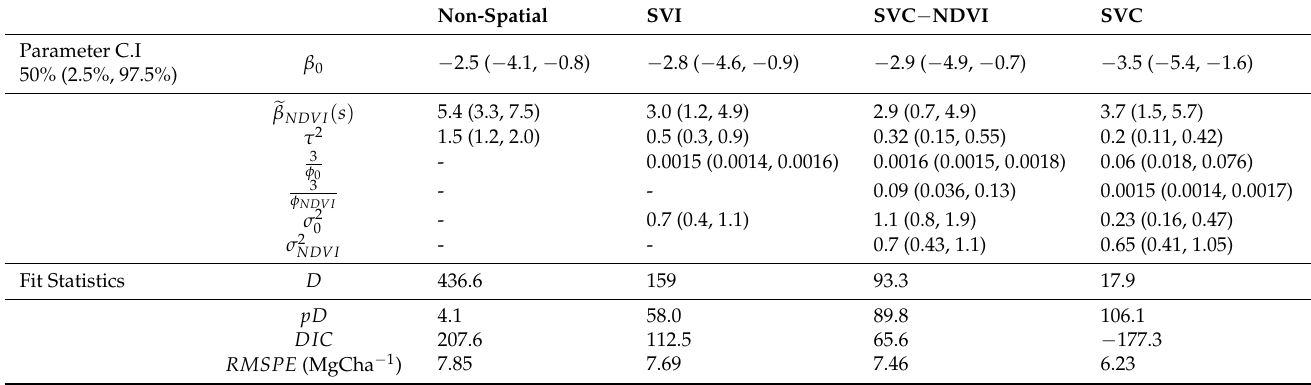
Table 3. Sentinel-2-based SVC model median parameter estimates alongside 95% credible